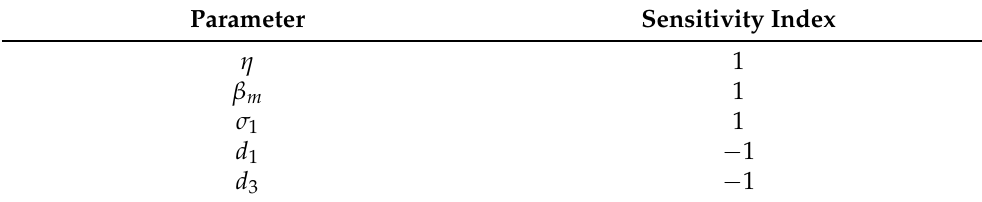
Table 2. Sensitivity indices of R 0 m